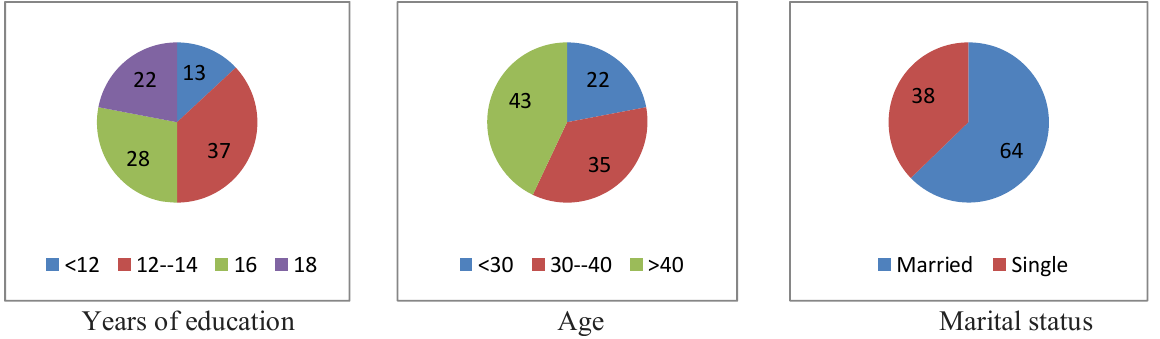
Fig. 1. Personal characteristics of the